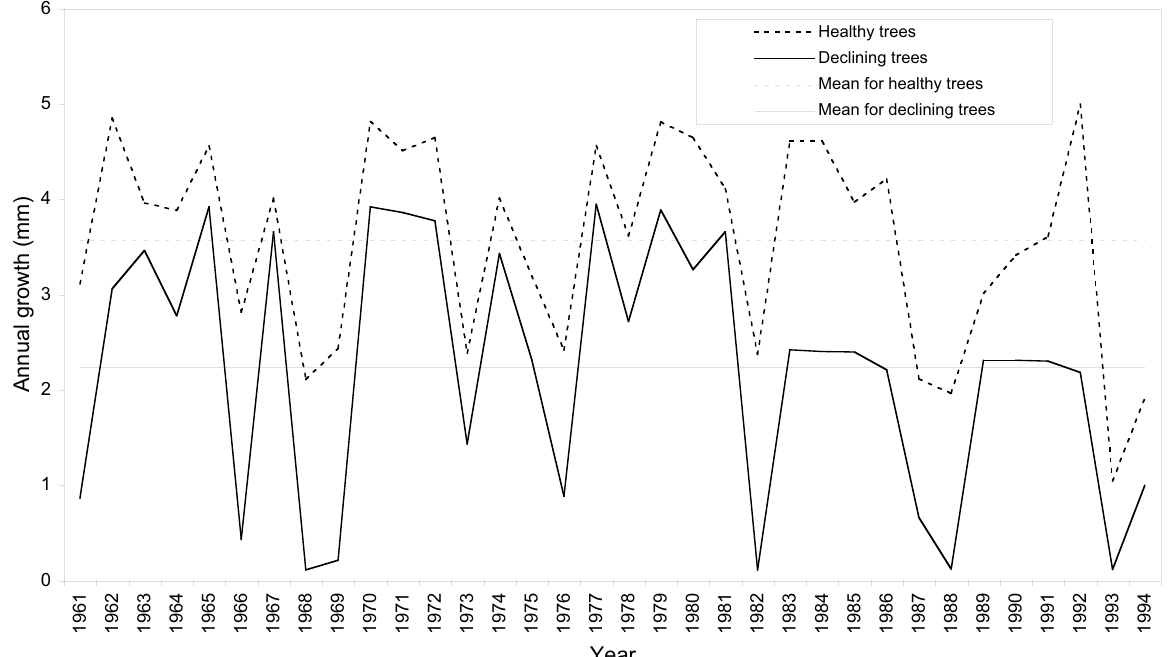
Fig. 1. Average growth curve from annual rings of declining and healthy Quercus robur trees near Fagarè, Padova, Italy.